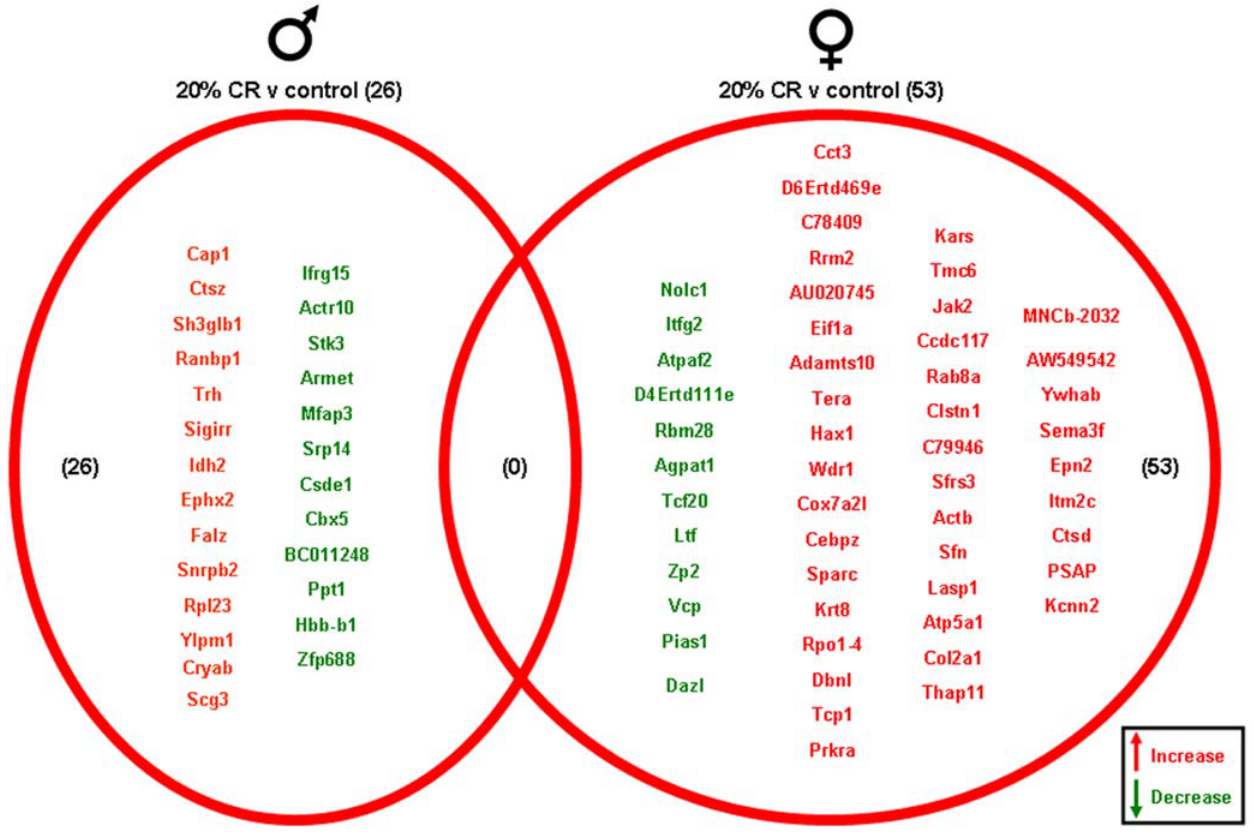
Figure 4. Hippocampi of male and female rats maintained on the 20% CR diet were compared to the hippocampi of male and female rats maintained on a control ( adlibitum ) diet. Genes that were significantly up-regulated (red) or down-regulated (green) were clustered into a Venn diagram. There were 14 significantly up-regulated and 12 significantly down-regulated genes in the hippocampi collected from 20% CR male rats compared to the genes from hippocampi collected from control ( ad libitum ) male rats. Hippocampi collected from 20% CR female rats showed 41 significantly up-regulated (red) and 12 significantly down-regulated (green) genes compared to the hippocampi collected from control ( ad libitum ) female rats. There were no significantly up-regulated or down-regulated common genes between male and female rats in this dietary group. Names of the significantly altered genes can be found in Table S1.